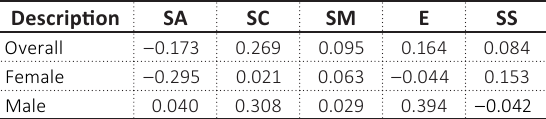
Table 1. Correlation coefficients of EI elements